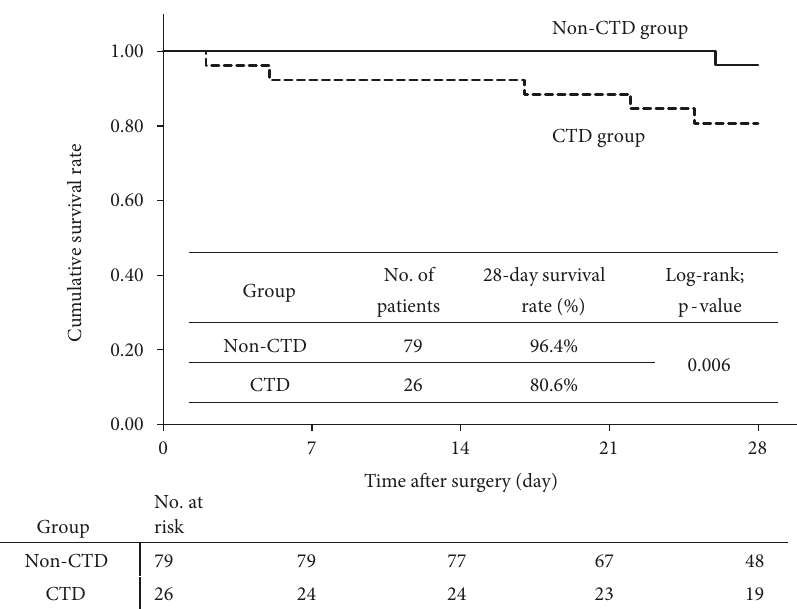
Figure 1: Cumulative survival curves based on the presence of connective tissue disease (CTD).